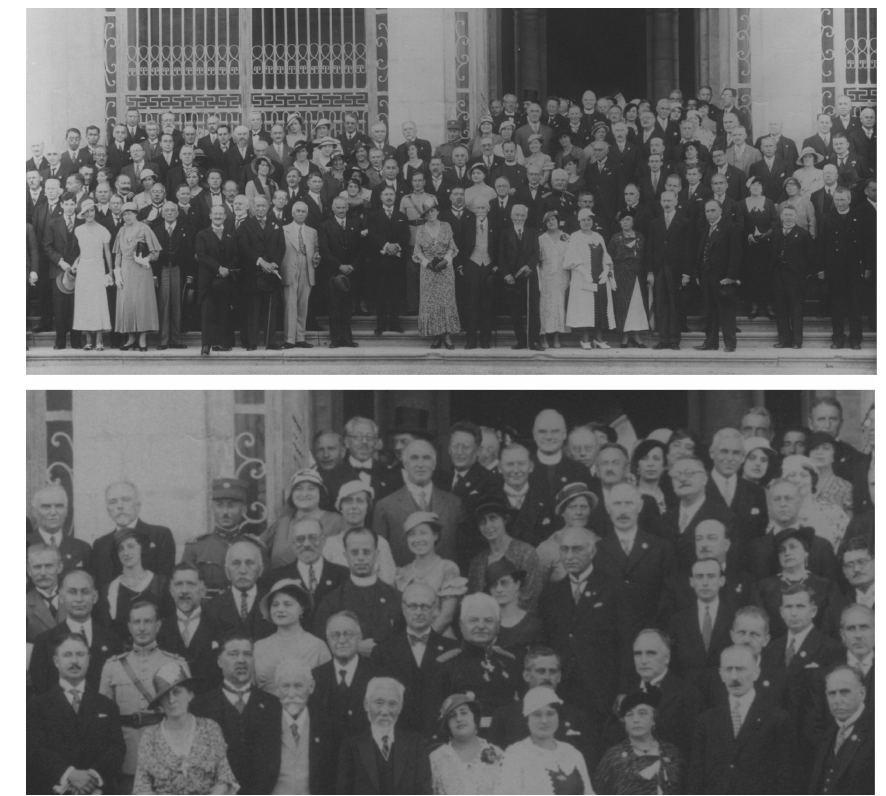
Figure 6. Participants of the Fifth General Assembly (upper panel); details of the central part of the photo (lower panel) (source: IUGG archives).